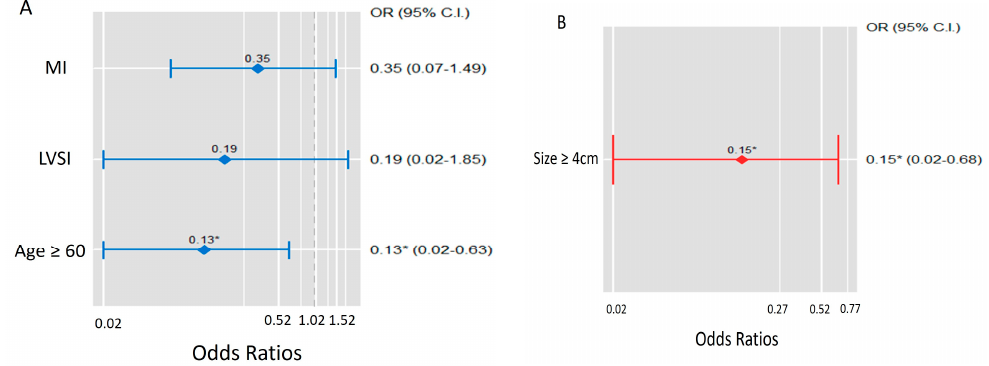
Figure 3. Visualization of odds ratios of YAP expression ( A ) and p -YAP expression ( B ) in endometrial cancer model. * Showed statistical significance.